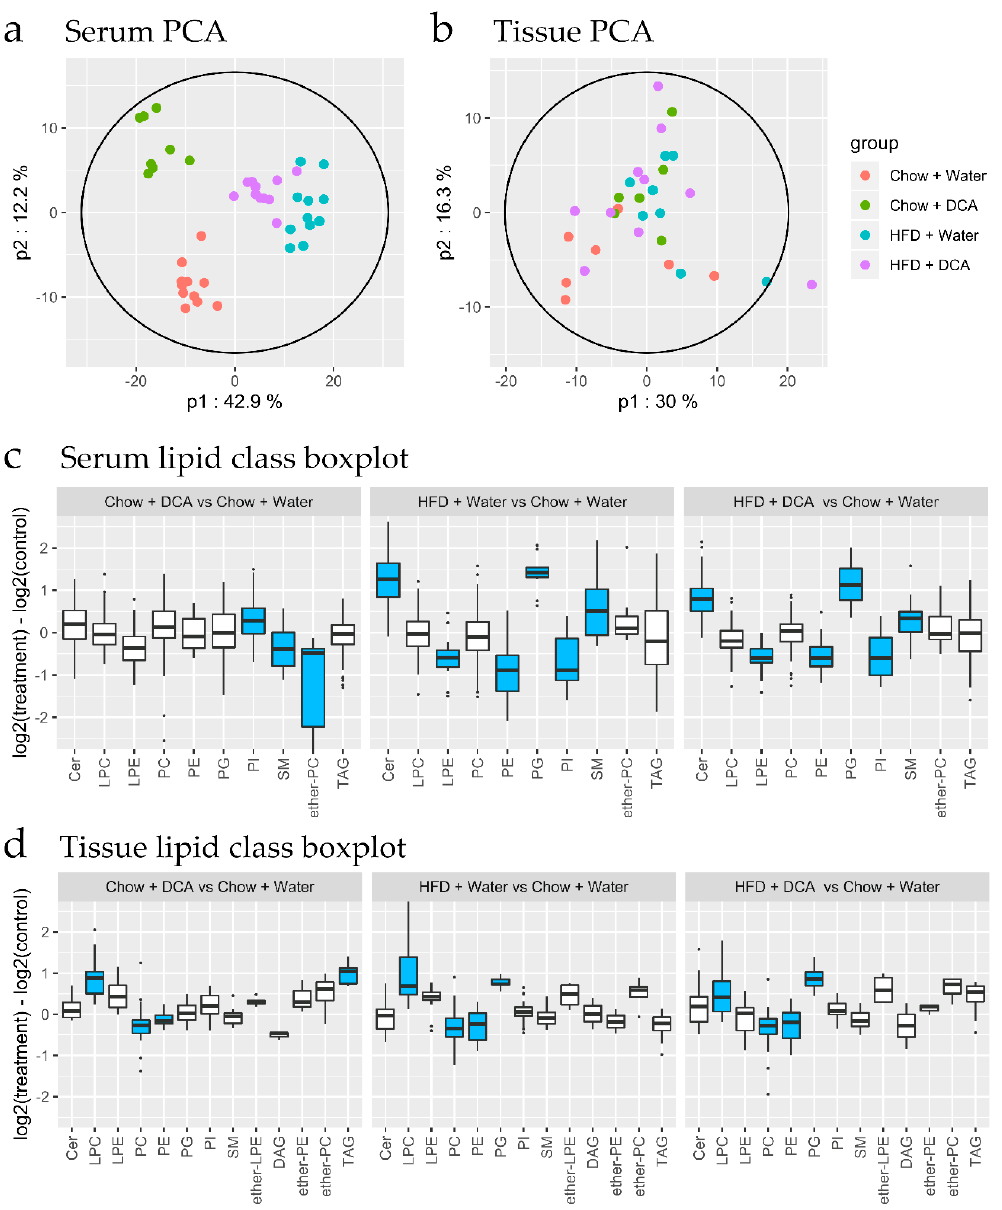
Figure 4. The impact of dietary interventions on tissue and serum lipidome. After 9 months high fat diet (HFD) +/- 0.2% deoxycholate (DCA), mouse gastroesophageal junction tissue and serum samples were subjected to lipidomics analyses. ( a ) Principal component analysis score plot of mean-centered unit variance-scaled untargeted serum lipidome data ( n = 38). ( b ) Principal component analysis score plot of mean-centered unit variance-scaled untargeted gastroesophageal junction tissue lipidome data ( n = 29). Plot ellipses represents the 95% Hotelling’s T2 confidence intervals for the multivariate data. ( c , d ) Lipid class boxplots for serum and gastroesophageal junction tissue lipids, showing the distribution of log2 differences between the treatment group and control. Positive values represent lipids that are more abundant in the treatment group than in the control group. Blue color indicates significant enrichment using the fast gene set enrichment analysis (fgsea) method. Cer—Ceramide,